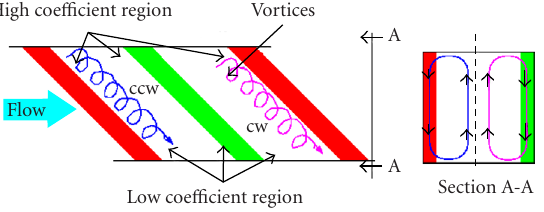
Figure 6: Cell formation for angled